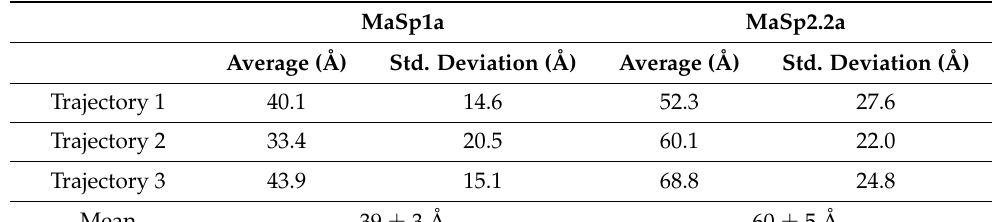
Table 1. Average values of the distance between the C α of the residues at the ends of the fragments, L (Figure 1), and their corresponding standard deviations for three independent MD trajectories of MaSp1a and MaSp2.2a in the absence of external force. The arithmetic mean and standard deviation calculated from these trajectory values for each fragment is indicated in the last row.